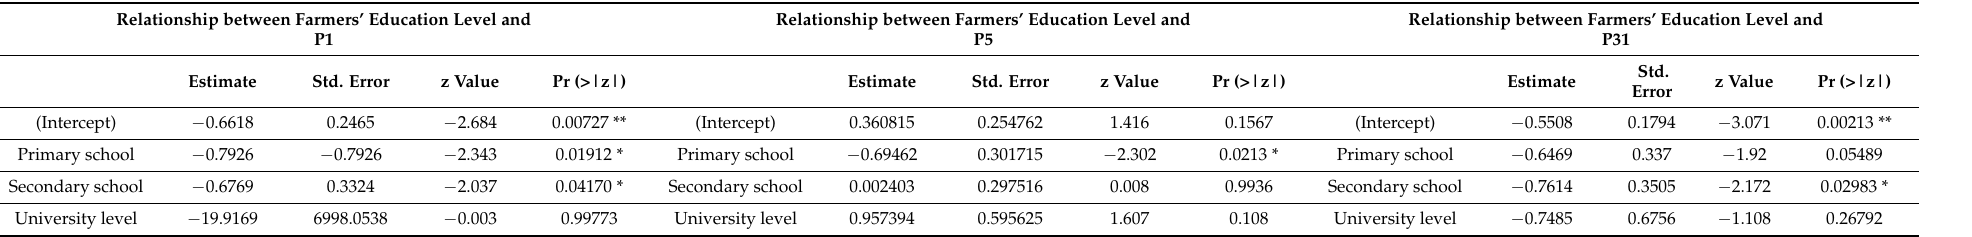
Table A3. Results of the generalized mixed effect model showing the relationships between farmers’ level of education and the adoption of CSAP for significant